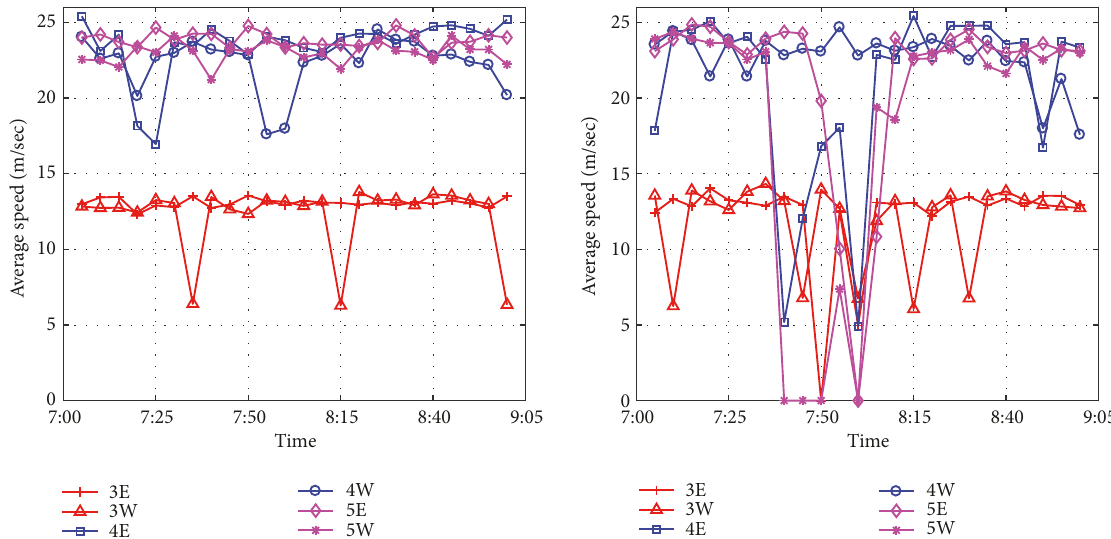
Figure 3: Examples of observed average speeds on road sections 3, 4, and 5 for both directions (direction east (E) and direction west (W)). Left: normal traffic scenario. Right: accident scenario (accident on the Grand Duchess Charlotte Bridge).